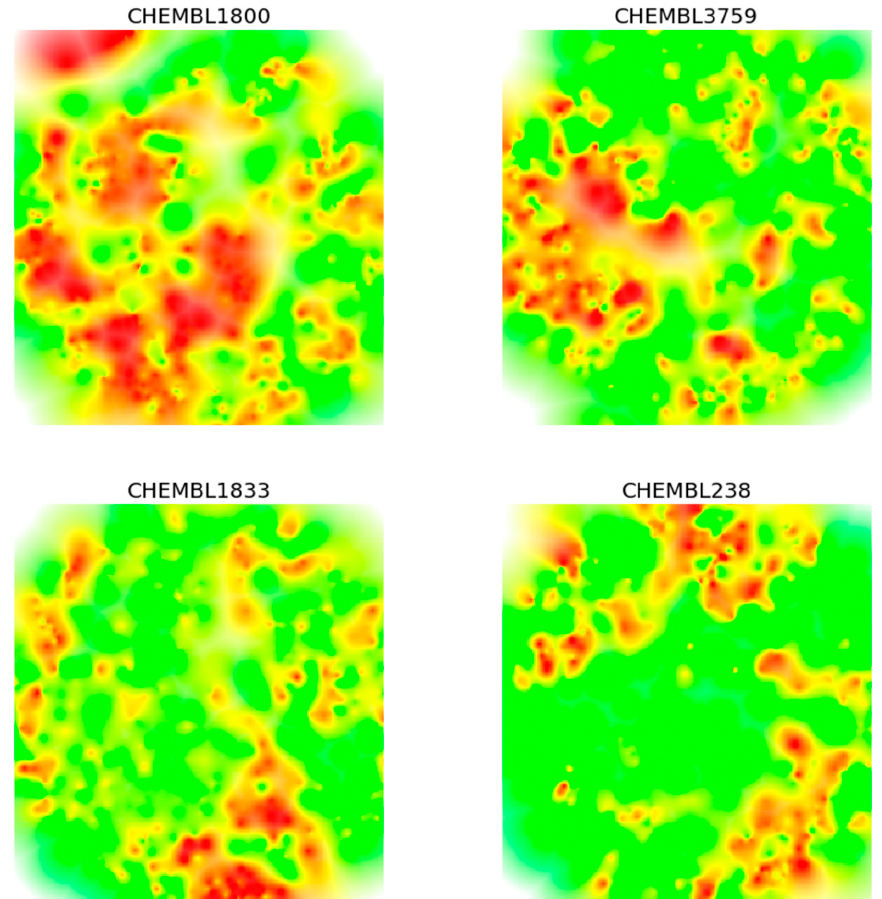
Figure 4. Heatmaps from different activity landscapes. Heatmaps derived from 3D ALs of four different compound datasets according to Table 1 are compared. Table 1. Datasets. The table summarizes the composition of four exemplary compound datasets (different activity classes) used for 3D AL analysis.